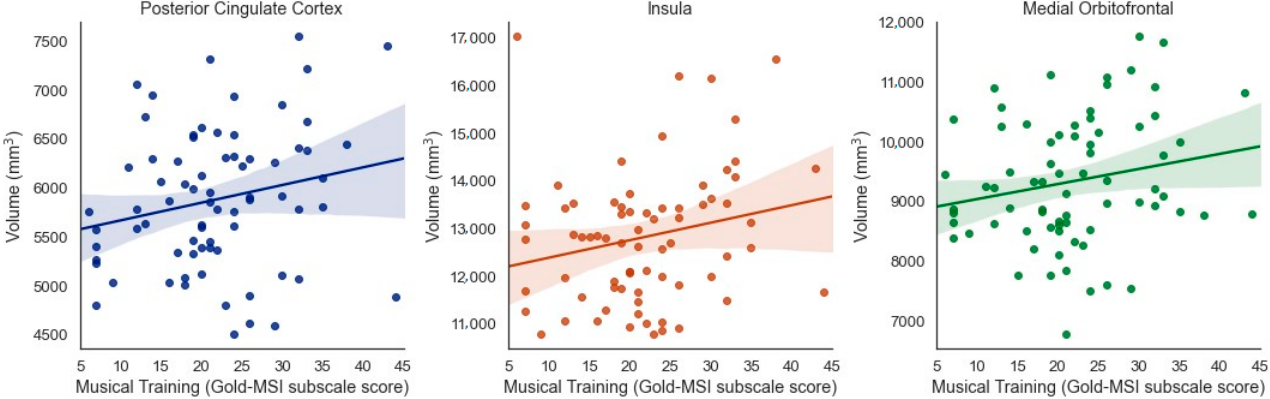
Figure 4. Positive associations between Musical Training (Gold-MSI) and volume of the bilateral posterior cingulate cortex, insula, and medial orbitofrontal cortex in older adults (uncorrected).